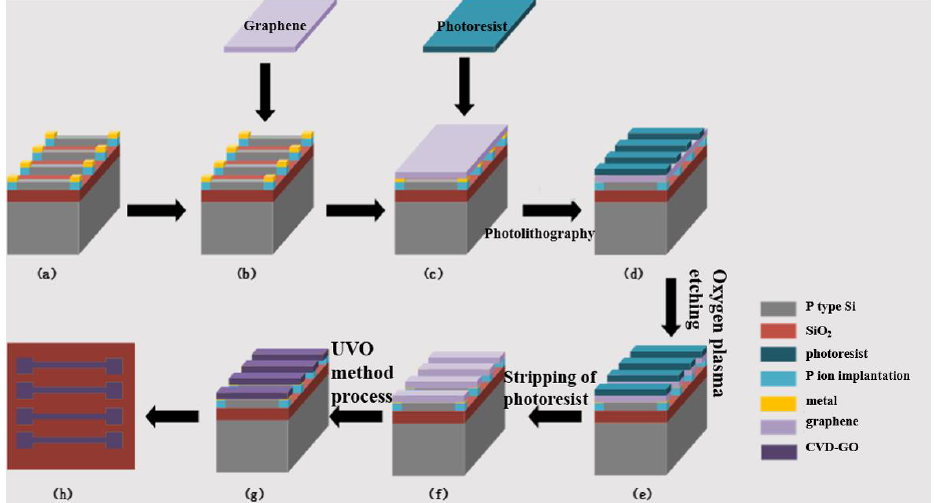
Figure 3. Process flow chart diagram of ion sensitive GO-Si based metal-semiconductor junction resistor gas sensor.